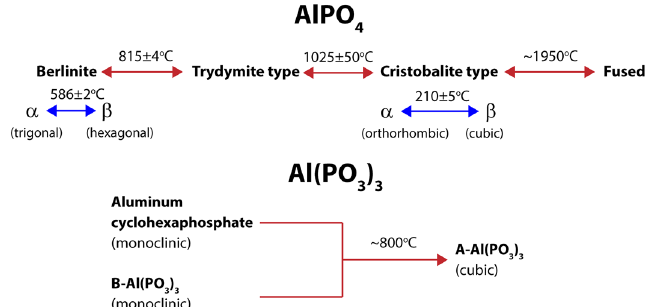
Figure 1. Thermal transformations of AlPO 4 and Al(PO 3 ) 3 . Crystal system in parentheses. Ref 4,28,30,33,38–41 .